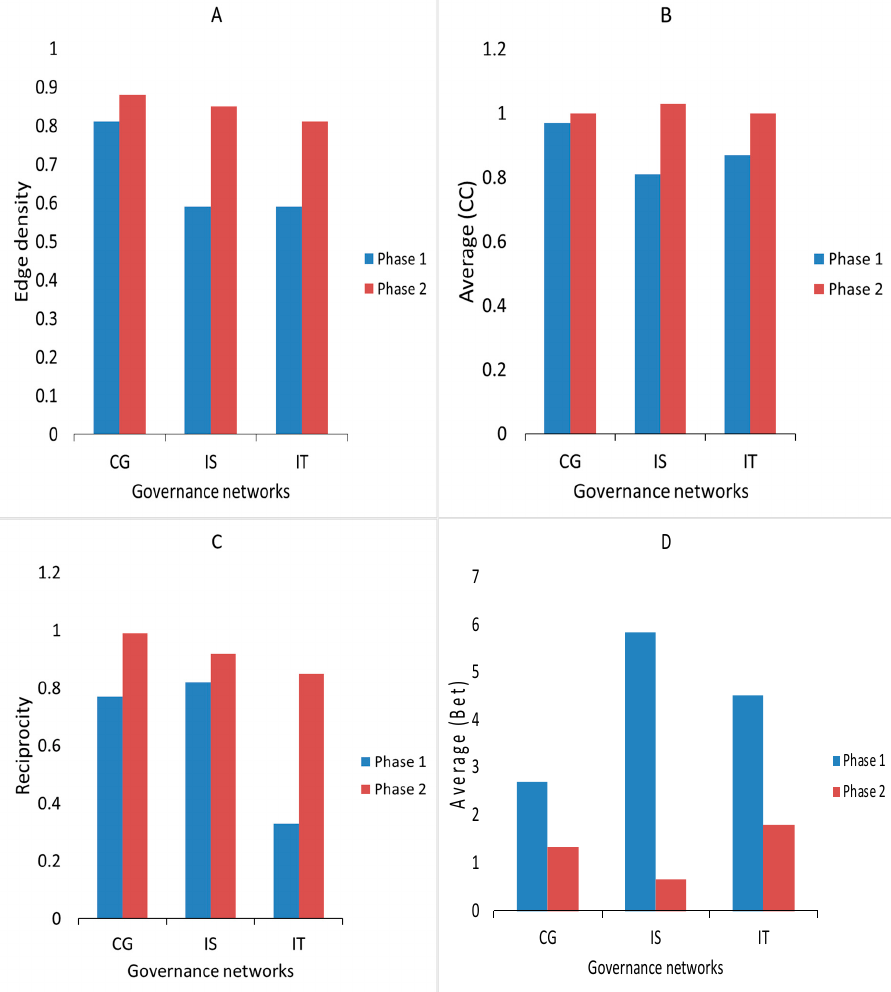
Figure 5. Network metrics evolution. ( A ) depicts changes in edge density; ( B ) changes in average Figure 5 : Network metrics evolution. 5A depicts changes in edge density; 5B changes in average clustering; 5C) changes in reciprocity; and 5D changes in average betweenness. CG (Common Goals clustering; ( C ) changes in reciprocity; and ( D ) changes in average betweenness. CG (Common Goals network), IS (Information Sharing network) and IT (Inter-organisational trust network). network), IS (Information-Sharing network) and IT (Inter-organisational trust